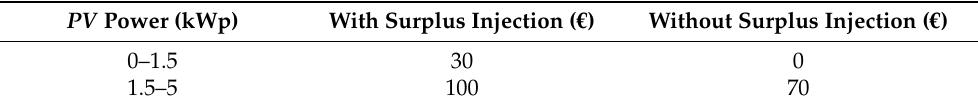
Table 2. Registration fee to operate as UPAC with and without surplus